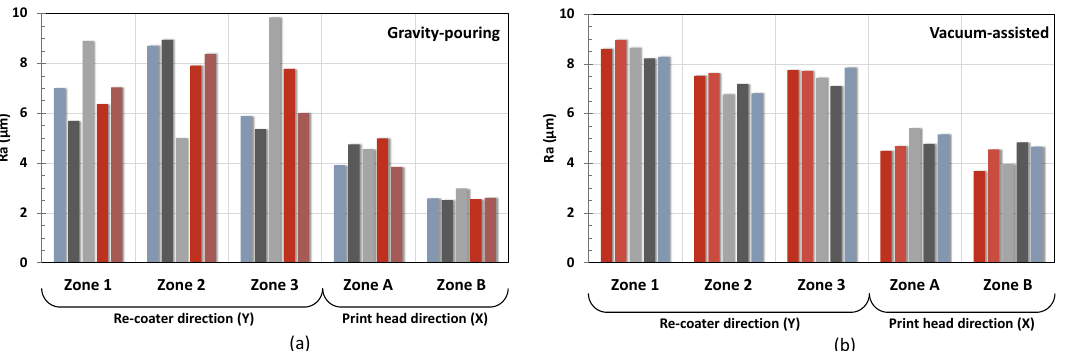
Figure 10. ( a ) Roughness distribution for the gravity-pouring part. ( b ) Roughness distribution for the vacuum-assisted part.